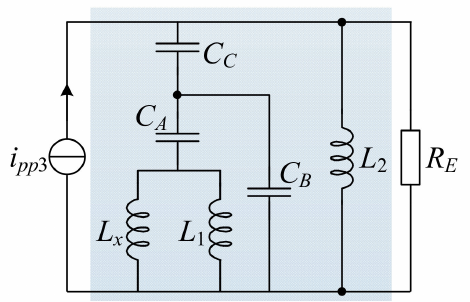
Figure 14. The simplified L x -PP CPT circuit using T-type model to realize CC